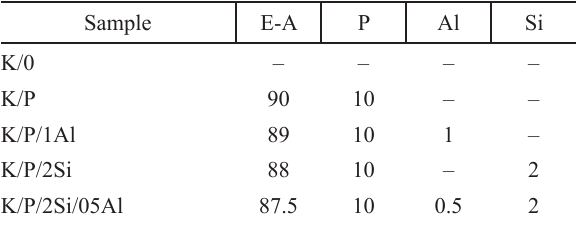
Table 1 – Composition of PCL nanocomposites (wt.%)